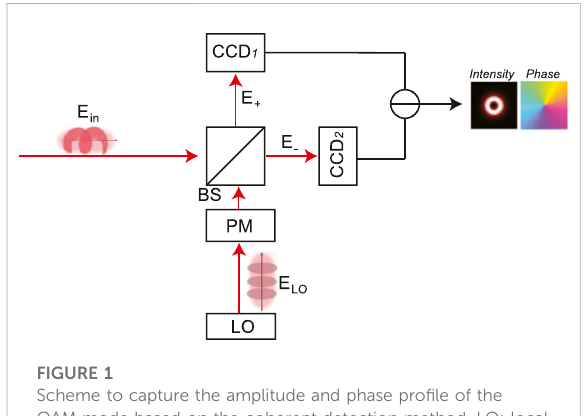
FIGURE 1 Scheme to capture the amplitude and phase pro fi le of the OAM mode based on the coherent detection method. LO: local oscillator. PM: phase modulator. BS: beam splitter.